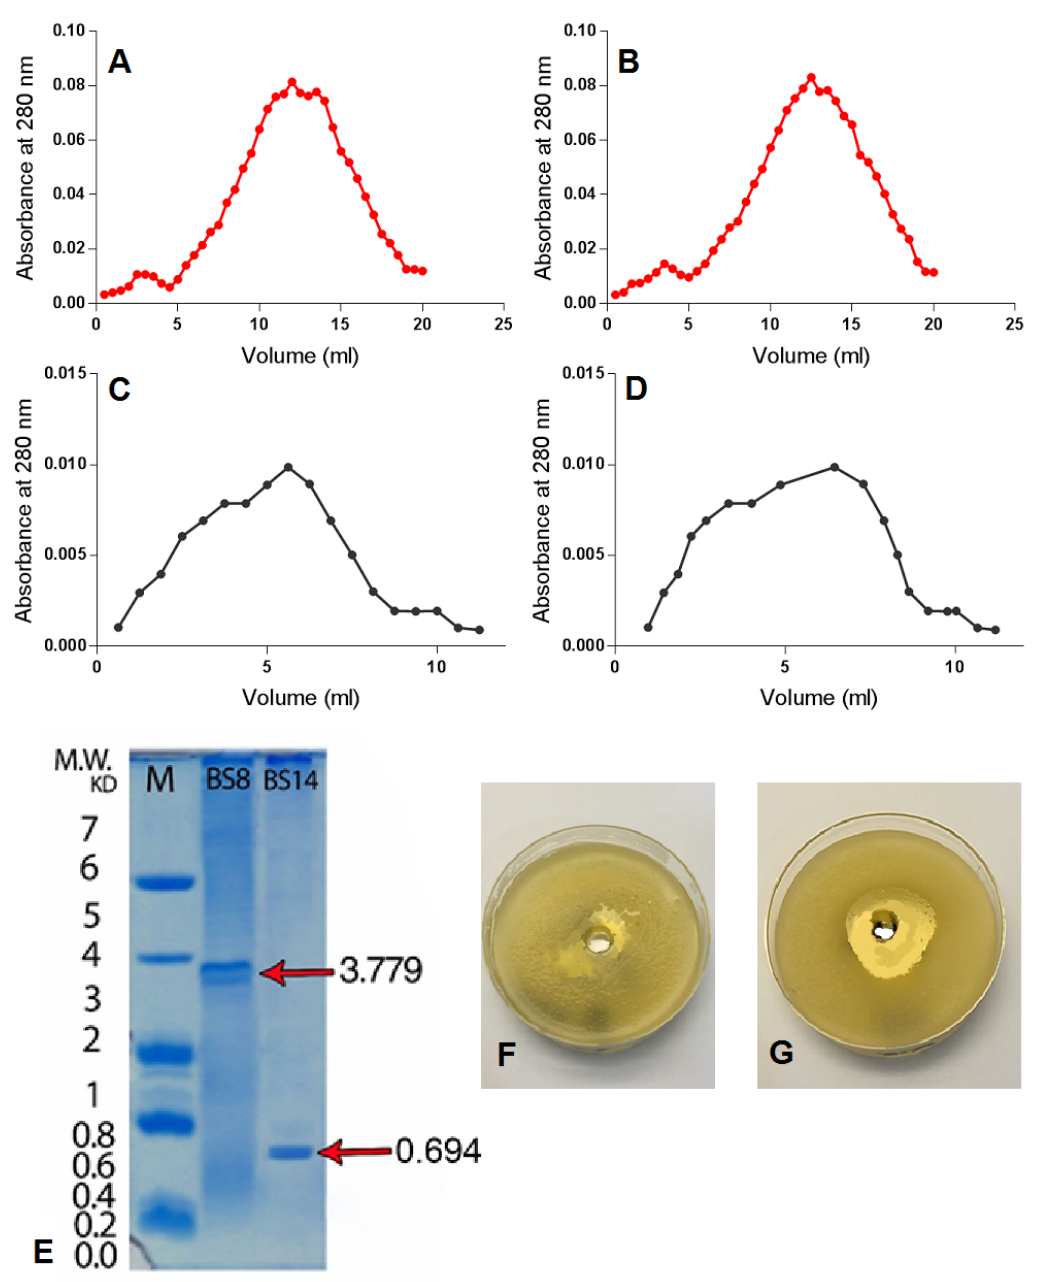
Figure 2. (A) (B) an d The elu tion profile of proteins from the DEAE colum n eluted with100 mM phosphate buffer (pH 7.0) for (BS8) and (BS14) samples respectively . Firs t peaks represe nt the (C) (D) unbound (effective) compounds, whil e th e second peaks ref er to th e bound positively charged (un- effective) compounds. and The elutio n profiles of purified prote in from the Sephadex S-200 colum n eluted with 100 mM phosphate buffer (pH7.0) for (BS8) and (BS14) sample s respectively . (F) (G) SDS-PAGE for the purified extracts compared with a n aprotin in polypeptide marker with a molecular P. aeruginosa (G) weigh t of 6.512 kDa. an d Antimicrobia l effec t of the purified secondary metabolites extracts BS14 extraction on BS8 extrac t